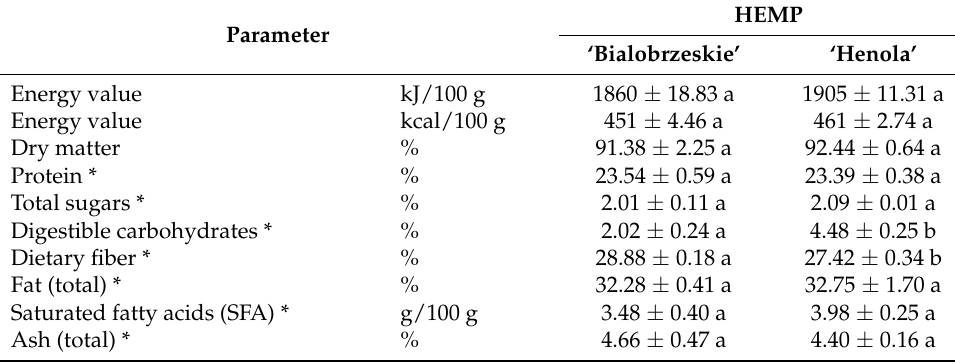
Table 1. Nutritional and energy value of hemp